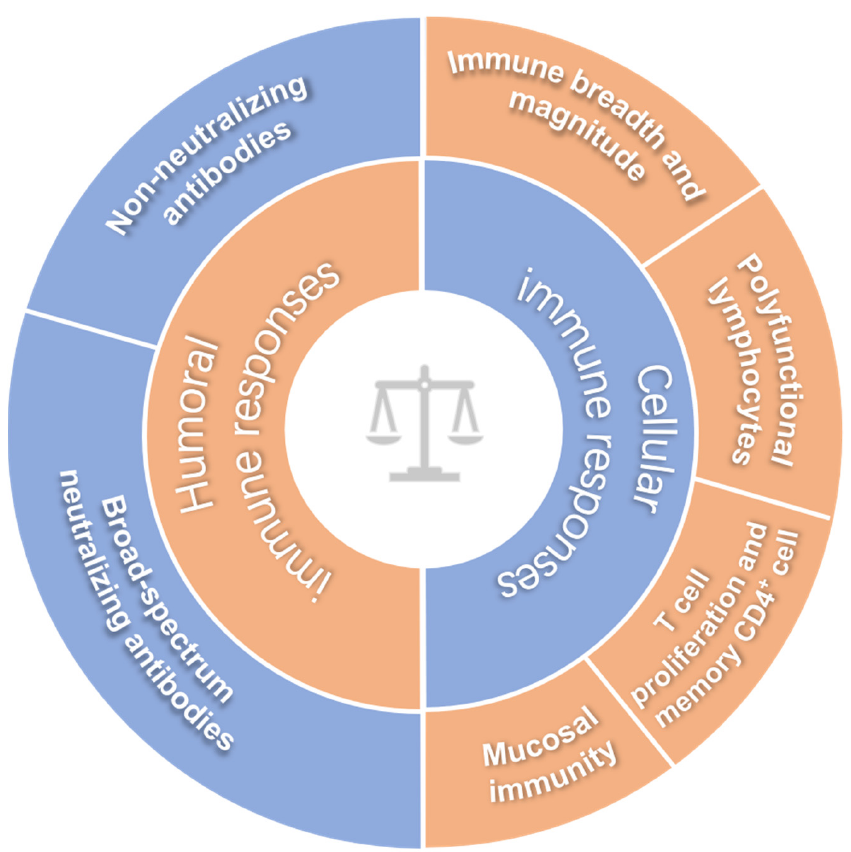
Figure 1. The inferred immune correlates of protection for HIV-1 vaccines.